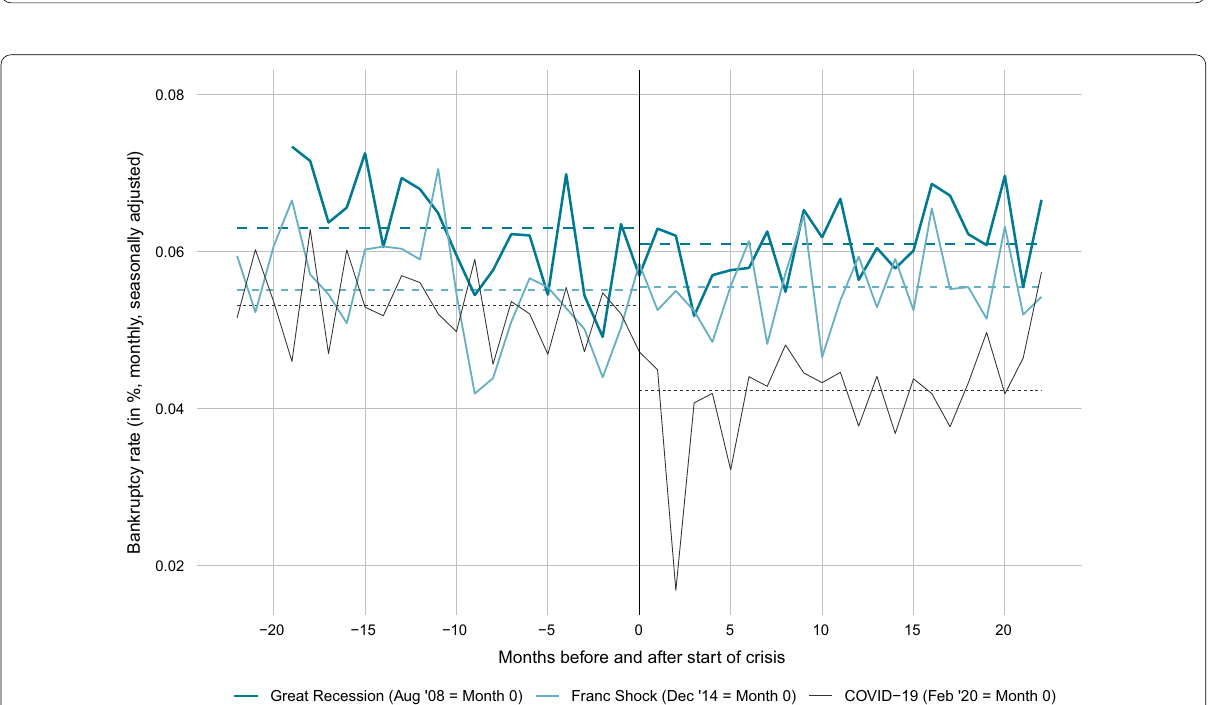
Fig. 17 Bankruptcy rate comparison excluding construction and crafts. Notes : The figure shows the monthly bankruptcy rate in the Swiss economy excluding firms in Construction and Crafts before and after the start of the Great Recession, the Swiss Franc Shock and the COVID-19 crisis. Month 0 is the last month before the crisis start. The dotted lines are the average bankruptcy rates over the 22 months before or after the respective crisis